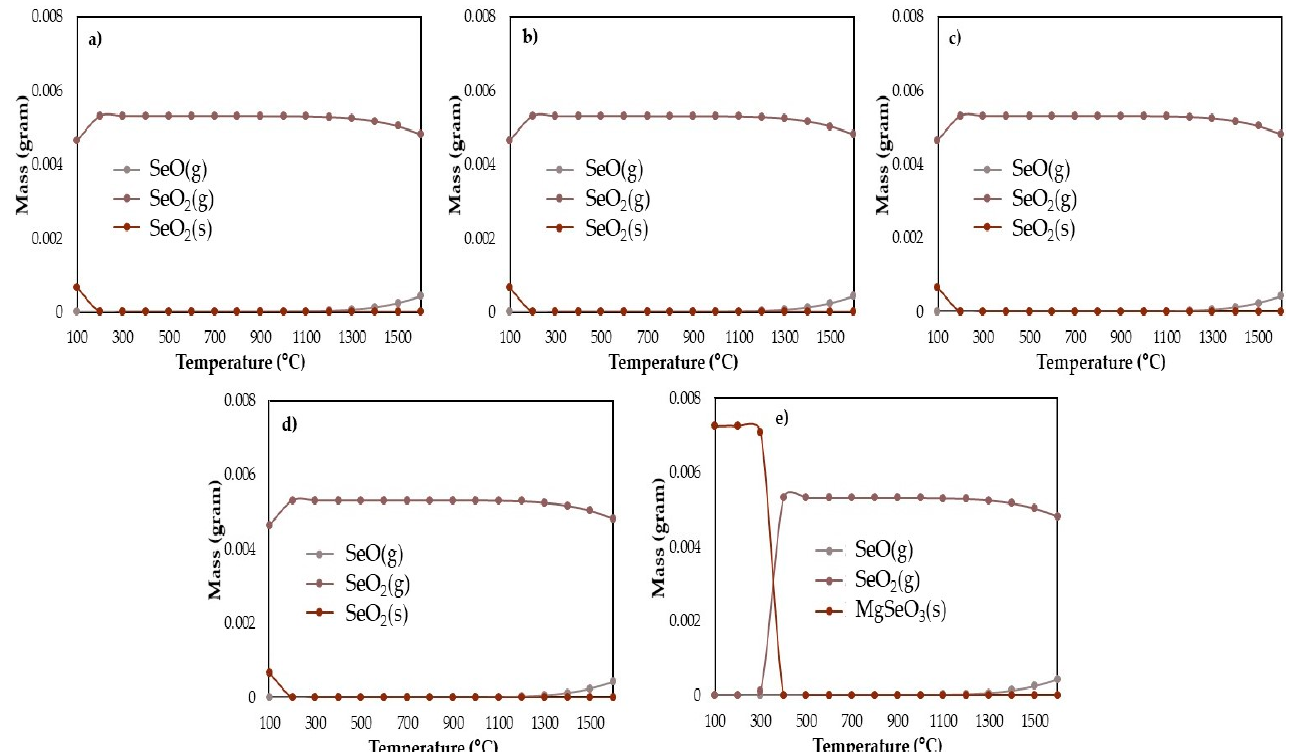
Figure 4. Equilibrium composition of F-Mineral oxides interactions during combustion: ( a ) F-O 2 -Al 2 O 3 ; ( b ) F-O 2 -CaO; ( c )